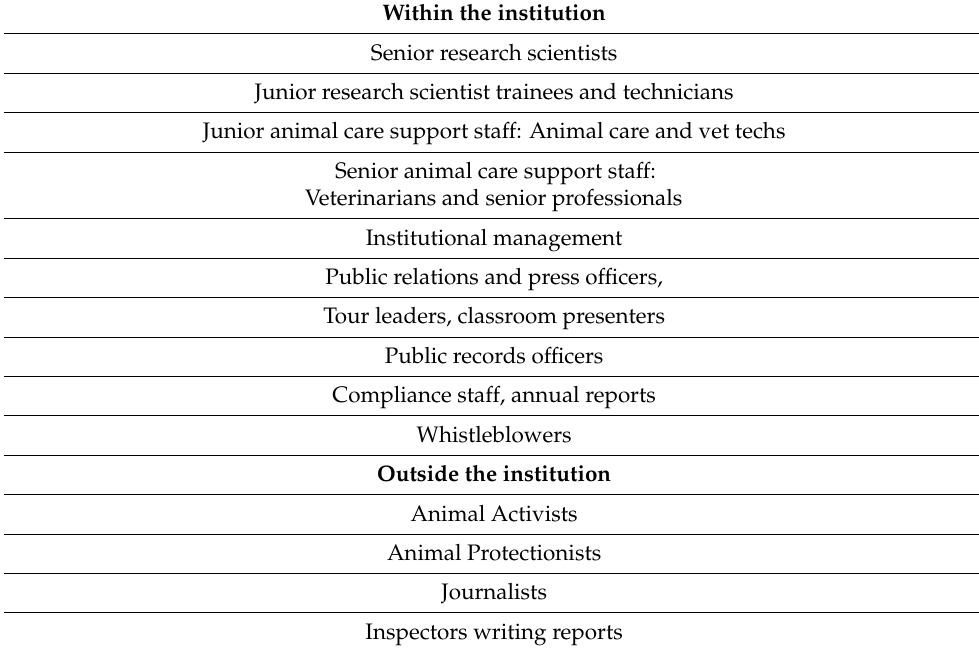
Table 1. Some potential sources of information on animal research